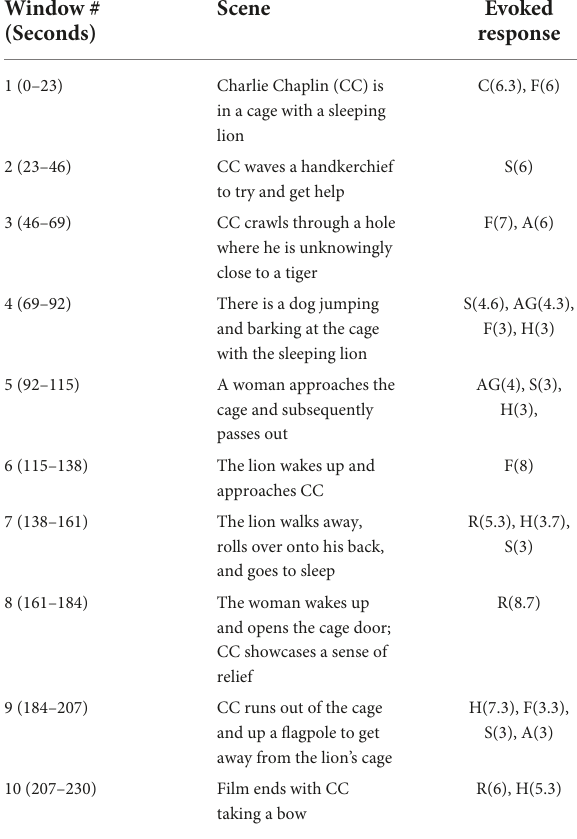
TABLE 2 Description of the 10 scene segments and potential evoked emotional responses as keyed by the authors. Window # (Seconds)